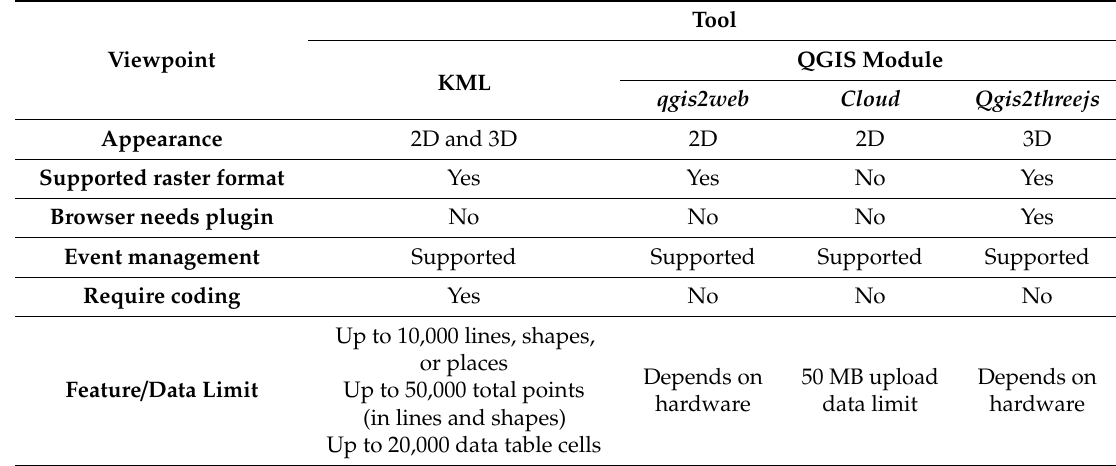
Table 1. Evaluation of